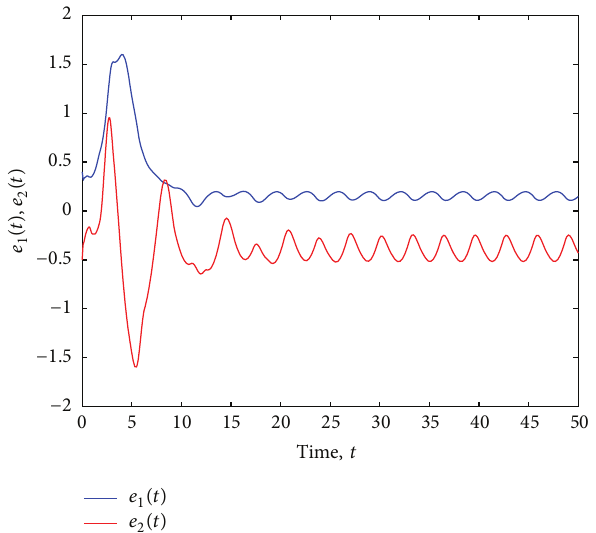
Figure 1: Synchronization error curves of the master system (52) and the slave system (53) without hybrid feedback control.